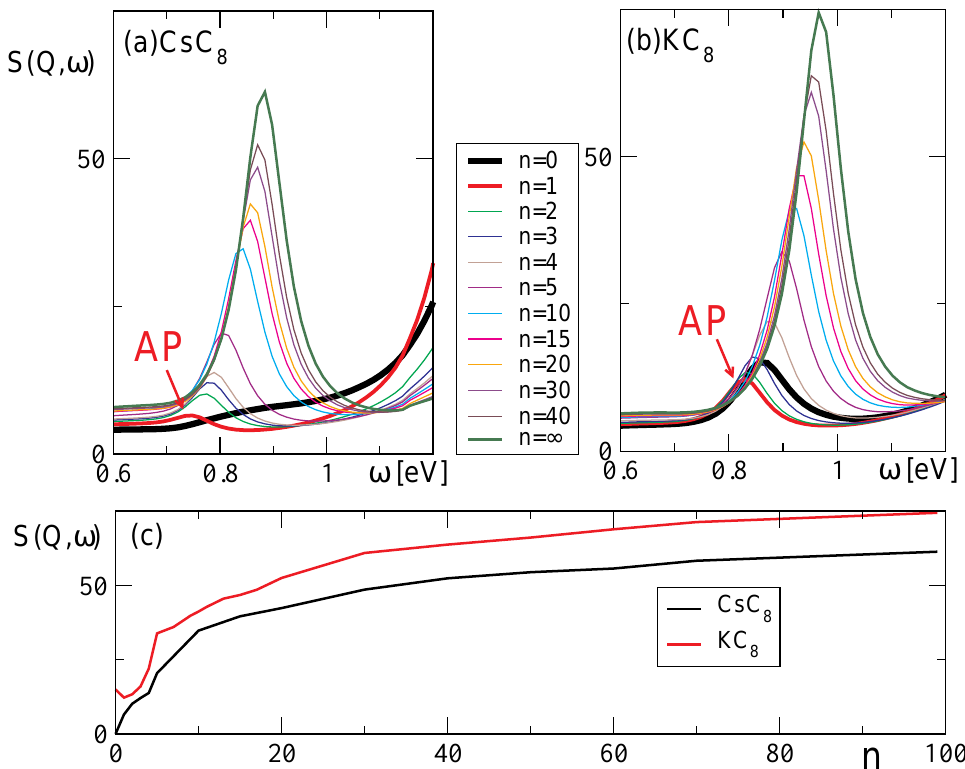
Figure 6. AP peak for Q = 0.1a.u. when various numbers of the unoccupied bands are omitted from the calculation ( n ) for the ( a ) CsC 8 and ( b ) KC 8 . ( c ) Intensity of the AP peak as a function of n for the CsC 8 (black line) and KC 8 (red